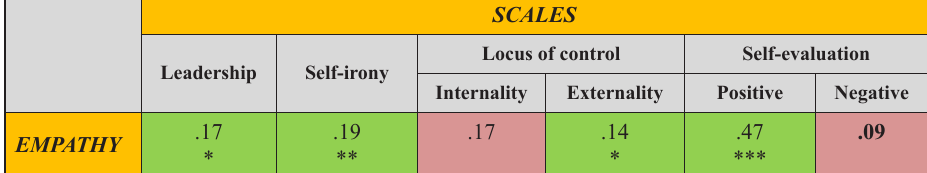
Table 1. Correlation (Spearman’s Correla- tion Coefficient) be - tween empathy and self- perception